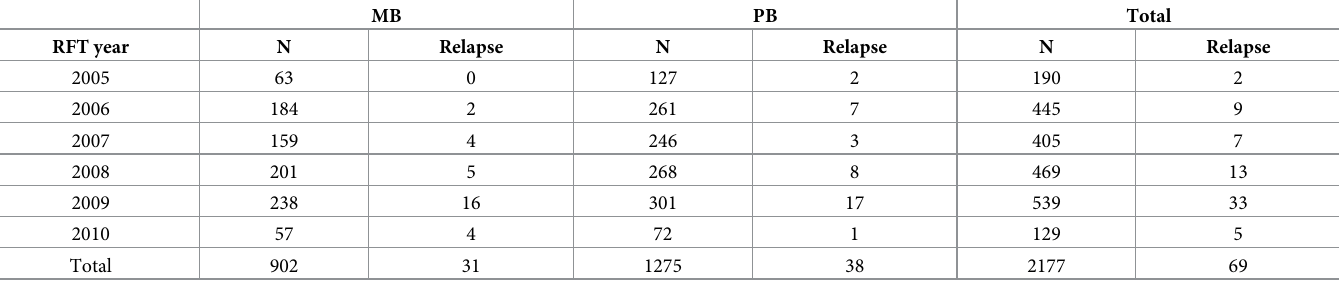
Table 1. Distribution of RFT patients and relapse events: Relapse and deformity among patients released from National Leprosy Eradication Programme of India: A cohort study from four districts in South India.